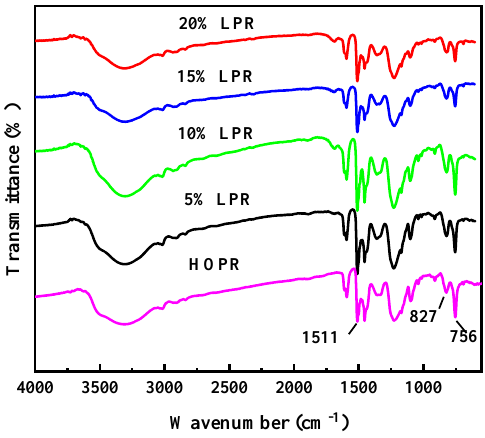
Figure 1. FT-IR spectra of LPRs with different lignin substitution